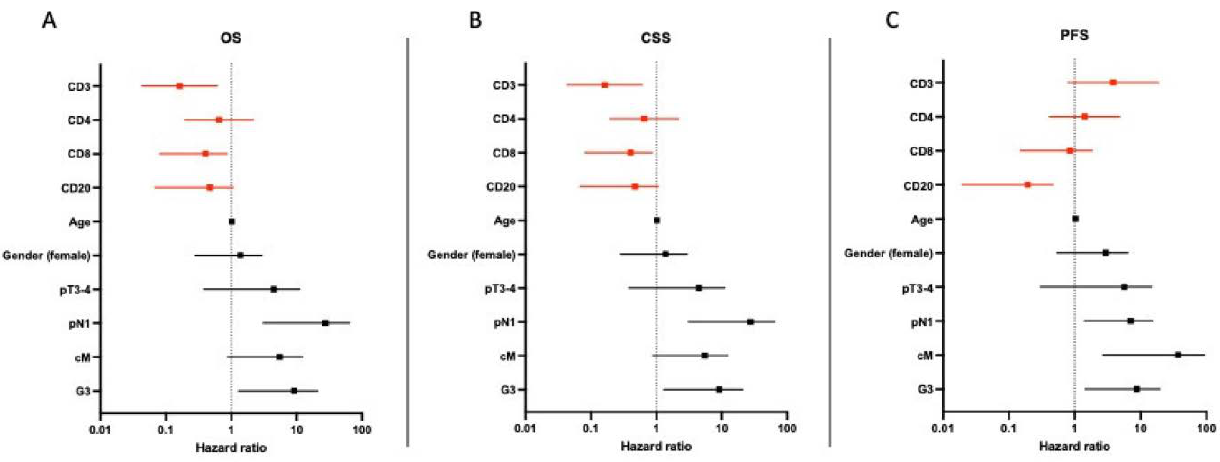
Figure 3. Multivariate analysis of predictors of overall, cancer-specific and progression-free survival in patients with pure SCC of the bladder. ( A – C ) shows hazard ratio for tumor specific parameters and its impact on OS, CSS and